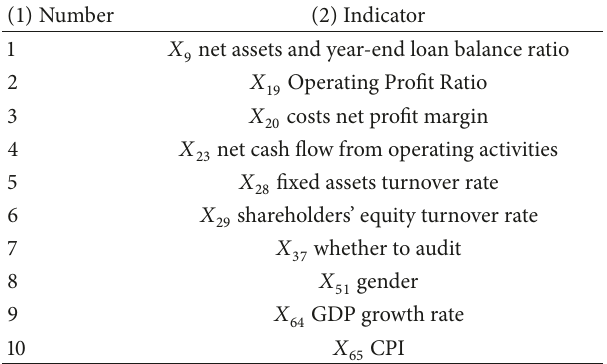
Table 4: The retained indicator after the first indicator filters. Table 5: Indicators selection based on R clustering